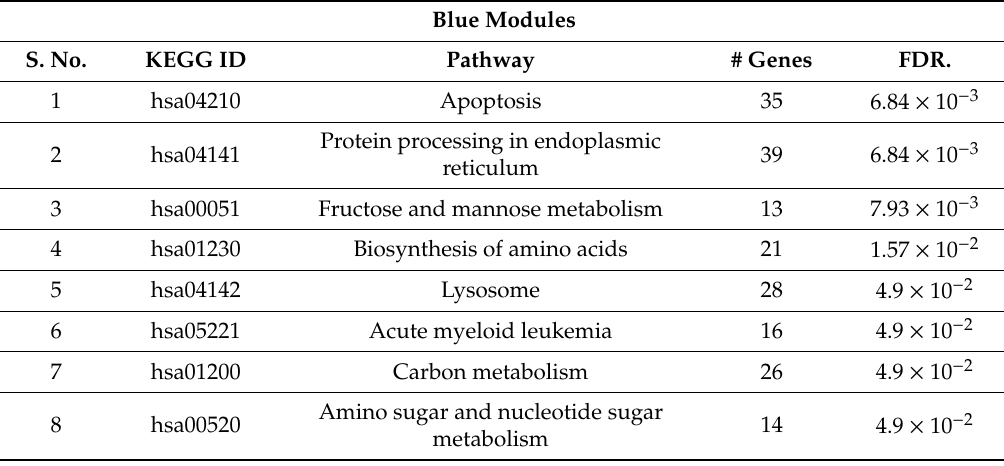
Table 12. Enriched KEGG pathways in relevant modules of subcutaneous datasets.